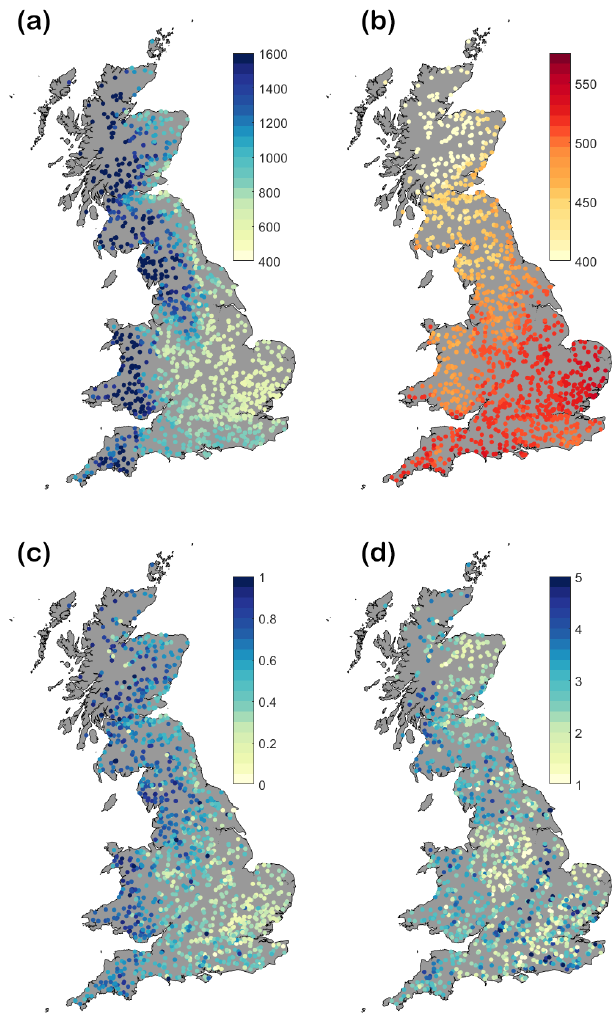
Figure 4. Hydro-climatic characteristics of 1366 GB catchments. (a) Annual rainfall (mmyr − 1 ). (b) Annual potential evapotranspi- ration (mmyr − 1 ). (c) Runoff coefficient (–). (d) Slope of the flow duration curve between the 30th and 70th percentiles (–). Minimum and maximum values on colour bars have been chosen to show clear differences between